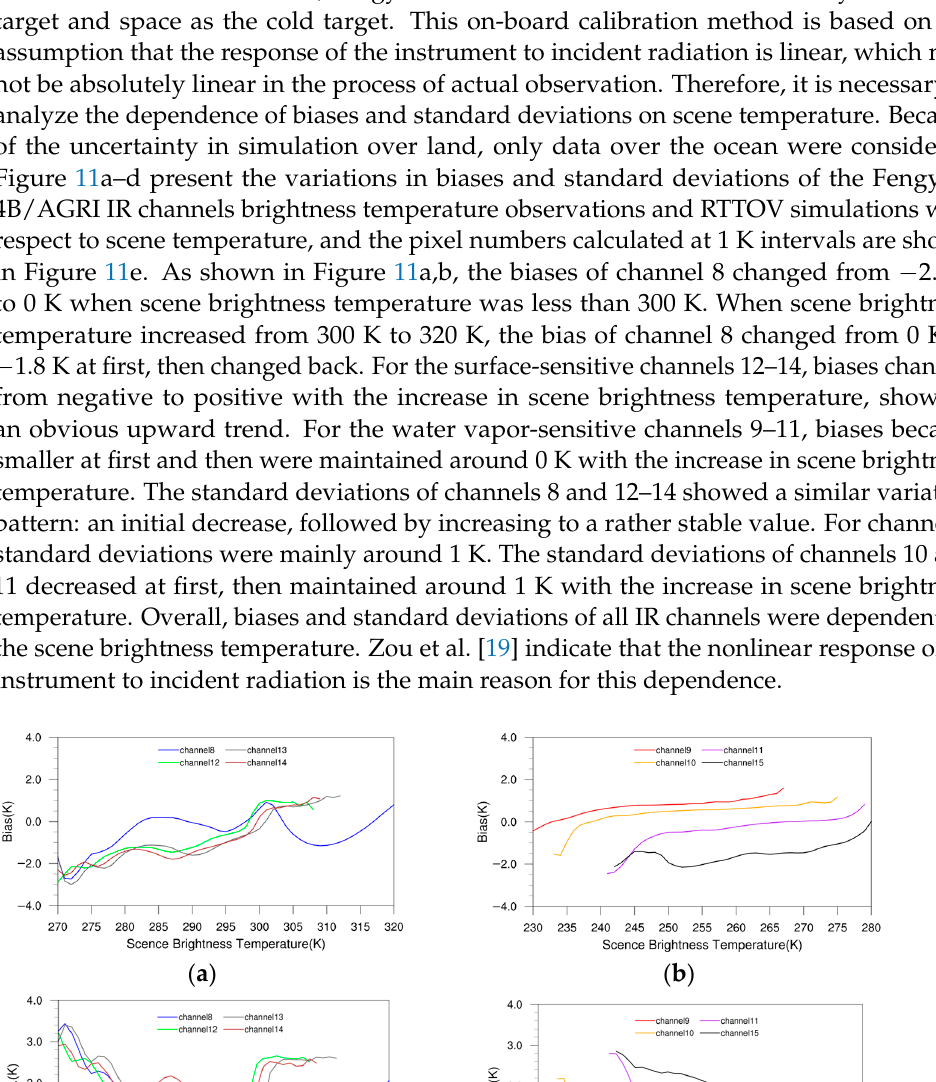
Figure 10. Biases ( a ) and standard deviations ( b ) of Fengyun-4B/AGRI IR channels’ brightness tem- perature observations and RTTOV simulations with respect to satellite zenith angles calculated at 1° intervals over the ocean under clear-sky conditions and with satellite zenith angles less than 60° from June to November 2022. Pixel numbers calculated at 1° intervals are shown in ( c ).